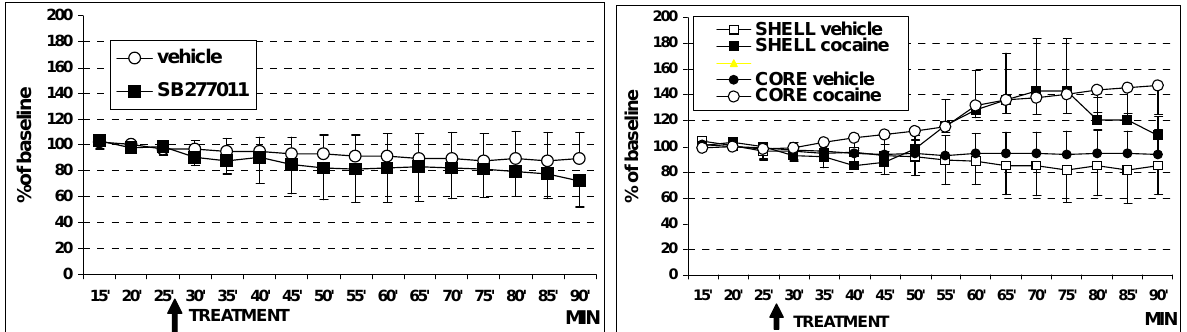
Figure 3 . Amperometric analysis of endogenous levels of DA in NAccore and in NAcshell. Data are expressed in percentage of the basal DA values preceding treatment(s). The last 15 min out of 30 min of basal recordings are illustrated: TOP: the arrow indicates the acute i.p. injection of vehicle (cavasol 10 %, open circles, n = 4) or that of SB-277011- A (10 mg/kg, black squares, n = 4). BOTTOM: the arrow indicates acute i.p. injection of vehicle (cavasol 10%, n = 4 each area) OR cocaine (15 mg/kg., n = 3 each area). Data are presented as mean ± SD.